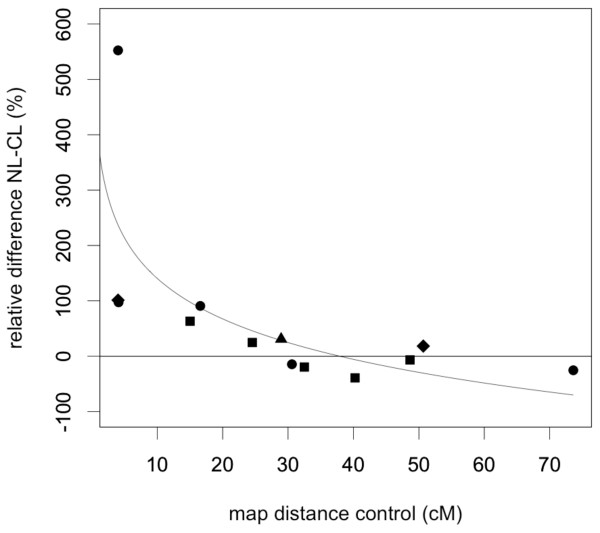
All possible direct comparisons of map length between paired control and coevolved lines. The graph covers thirteen corresponding (paired) intervals (x-axis). To account for zero values, one observation was added to all recombinant counts and to all total counts; hence, recombination frequency is calculated as: nrecombinants + 1/ntotal + 1. Recombination frequencies were transformed into map distances. Shown is the significant logarithmic relationship between the relative difference in percentages of coevolved (NL) and control lines (CL), and the observed map lengths in the control lines (linear regression, n = 13, F1, 11 = 10.188, P = 0.009, R2 = 0.481). This indicates that observed recombination frequencies are higher in coevolved lines compared to control lines. Symbols indicate from which line each data point originates: a triangle for line 3, a square for line 4, a circle for line 5, a diamond for line 6.